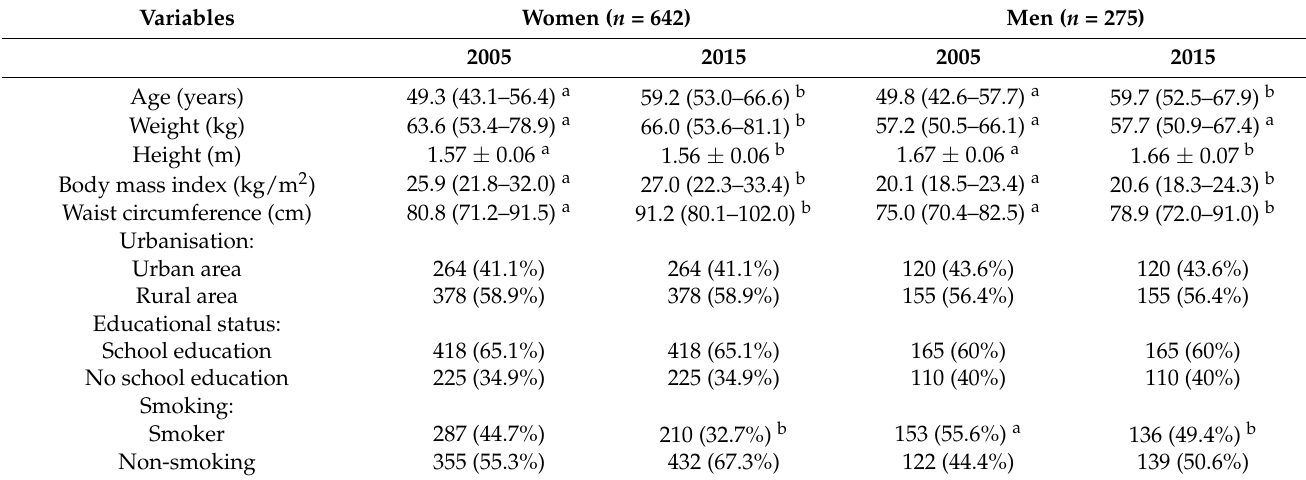
Table 1. Demographic, anthropometric variables and smoking habits of male and female